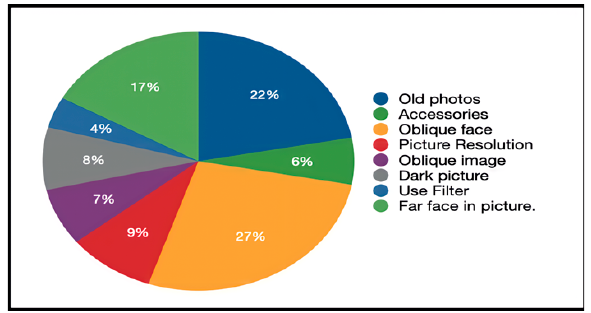
Figure 15. Reason behind not recognize the faces.